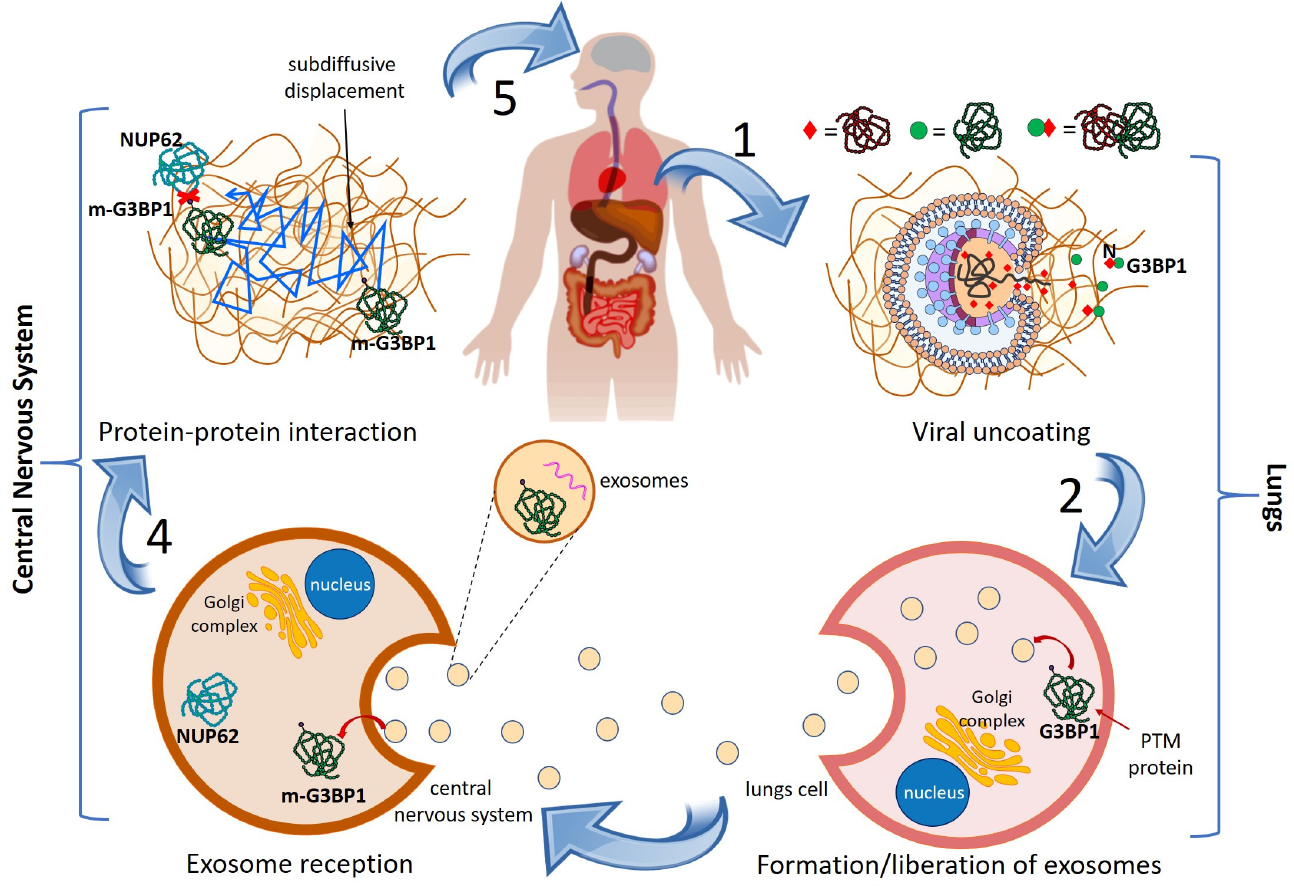
Figure 1. General mechanism of lungs-to-CNS cascade giving rise to PD in COVID-19 patients. See text for